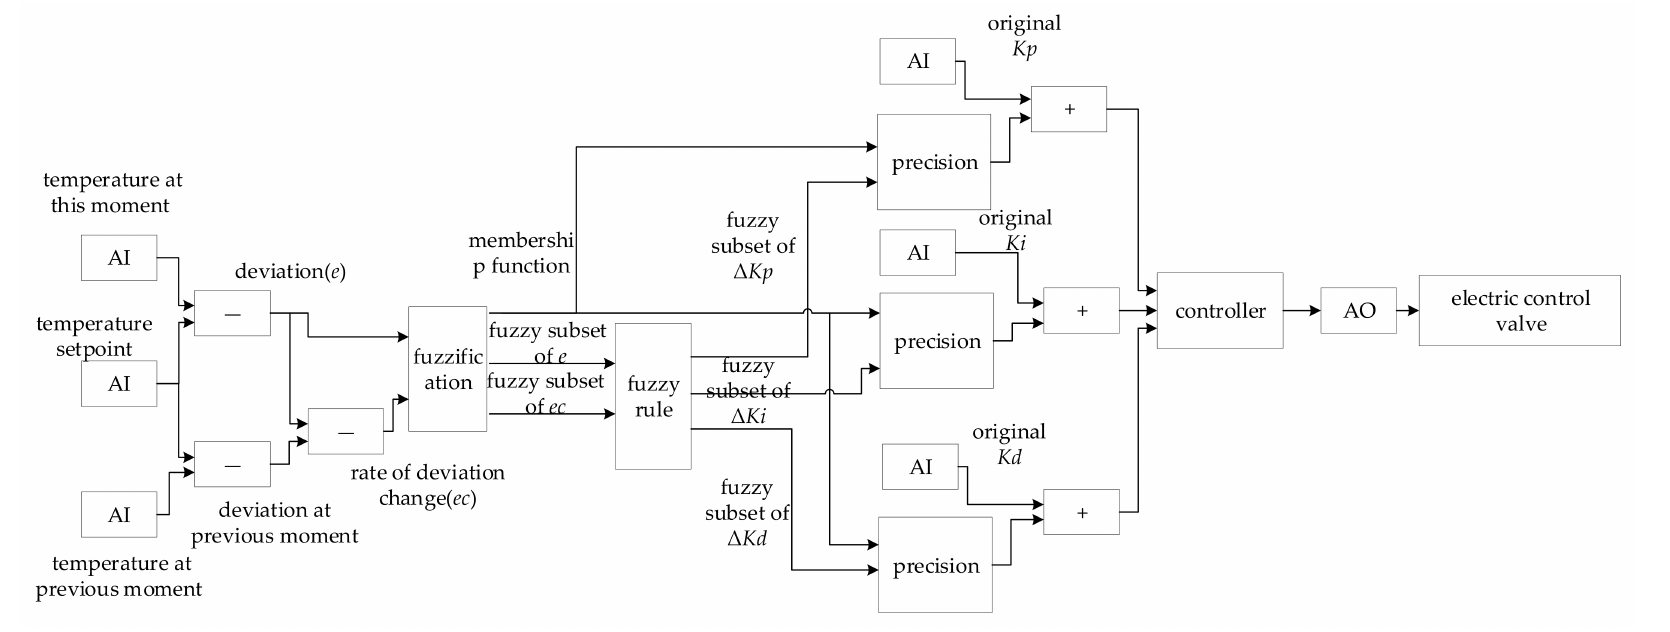
Figure 4. Fuzzy PID controller